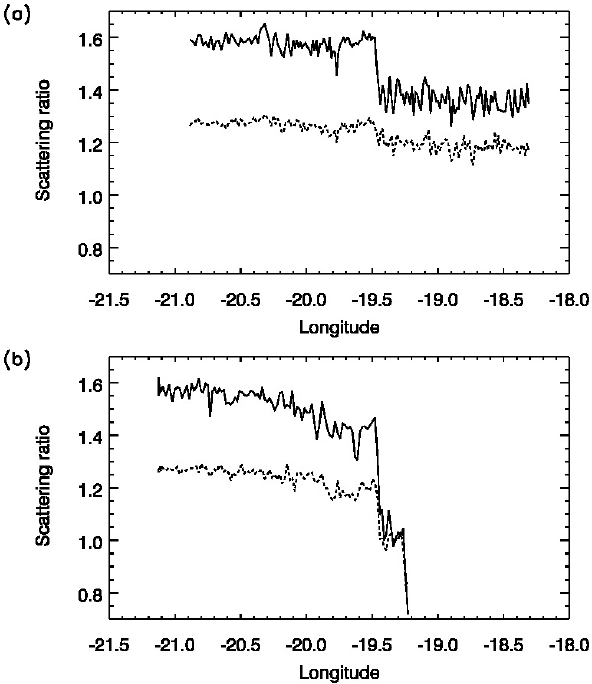
Fig. 14. Aircraft measurements of scattering ratio from the Rose- mount pair inlet nephelometer for (a) 400m height and (b) 700m height. The values shown are 10 second averages. The solid line shows the ratio between red and blue, the dashed line the ratio be- tween red and green. Note that scattering ratios for 1900m height are not shown here, because of the poor signal to noise ratio due to low particle number concentrations occuring at this flight